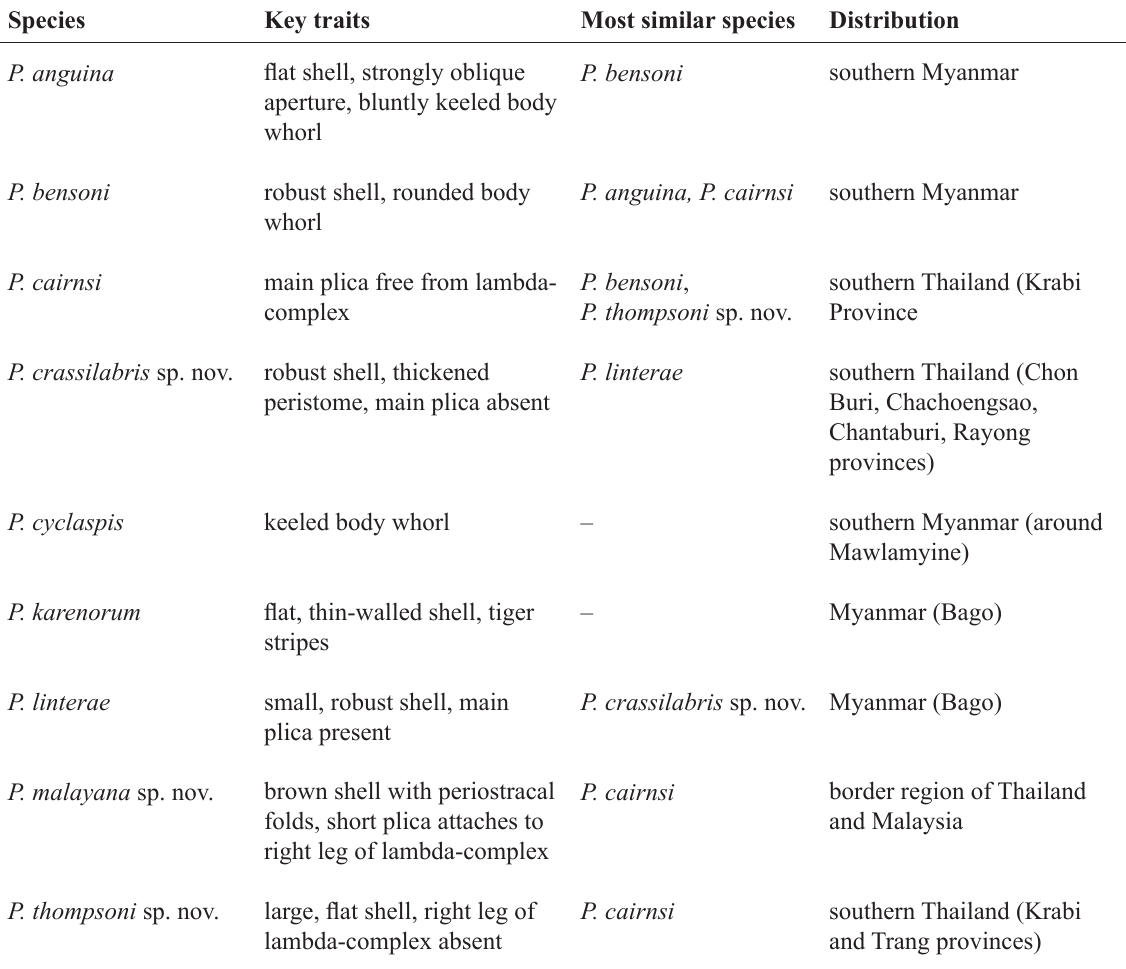
Table 3. Key characters, most similar species and distribution of species of Plectopylis . Species Key traits Most similar species